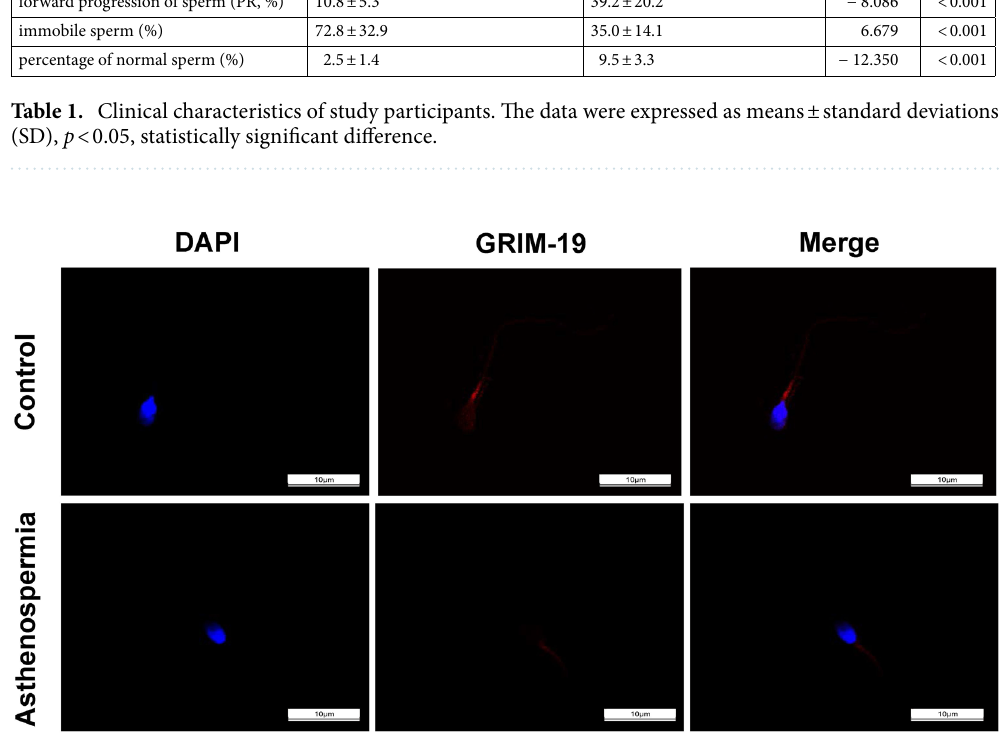
Figure 1. Immunofluorescent staining was carried out to investigate the subcellular localization of GRIM-19 in the sperm. DAPI (4 ′ ,6-diamidine-2-phenylindole) staining is shown on the left, middle column is GRIM-19 staining, the merge image is shown on the